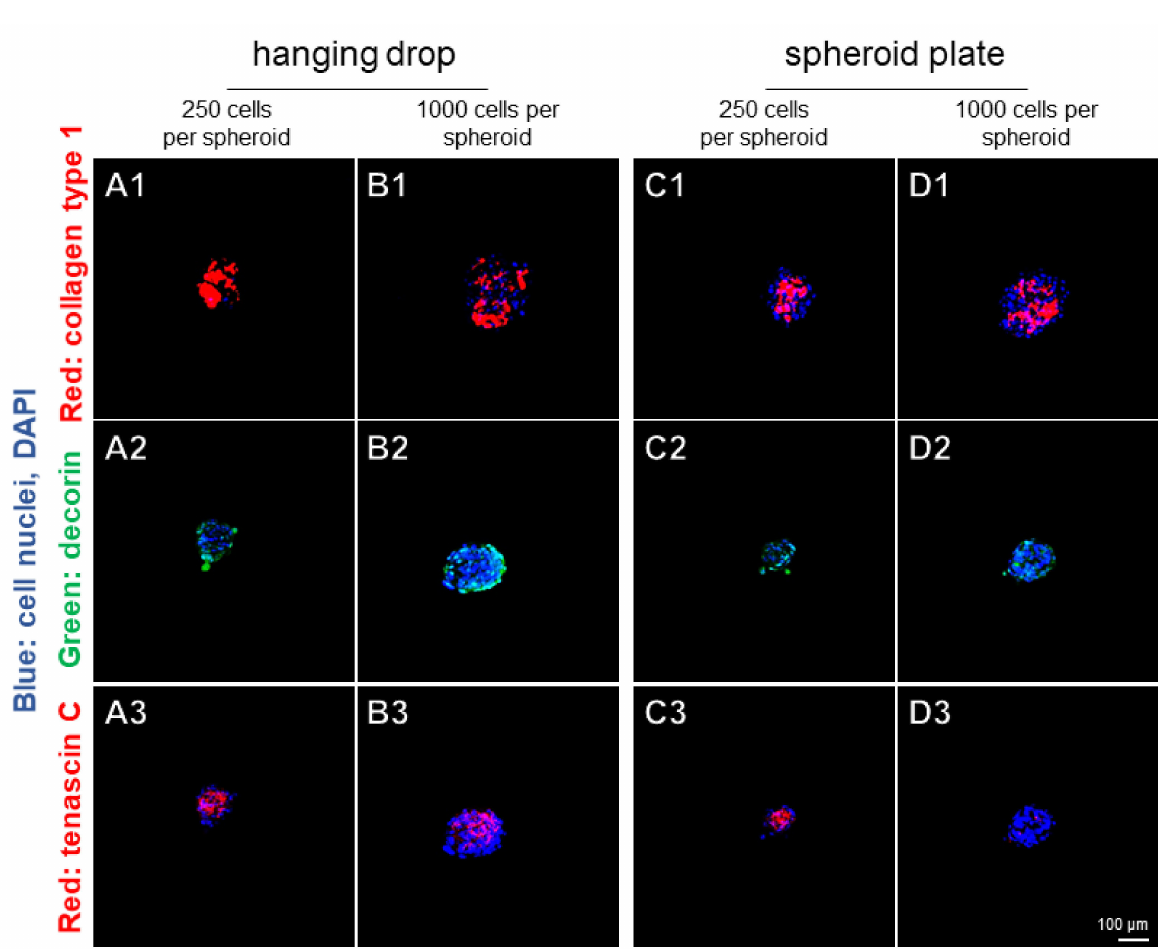
Figure 6. Distribution of ligament-related ECM components in spheroids prepared in hanging drops or using the spheroid plate after 7 days. ( A1 – D1 ) Collagen type 1 (red), ( A2 – D2 ) decorin (green) and ( A3 – D3 ) tenascin C (red). Cell nuclei were counterstained using 4’,6-diamidino-2-phenylindole (DAPI). Hanging-drop-derived spheroids consisting of 250 ( A1 – A3 ) or 1000 ( B1 – B3 ) ligamentocytes. Spheroids prepared by the spheroid plate consisting of 250 ( C1 – C3 ) or 1000 ( D1 – D3 ) ligamentocytes. Representative images are shown from three independent experiments. Scale bar: 100 µ